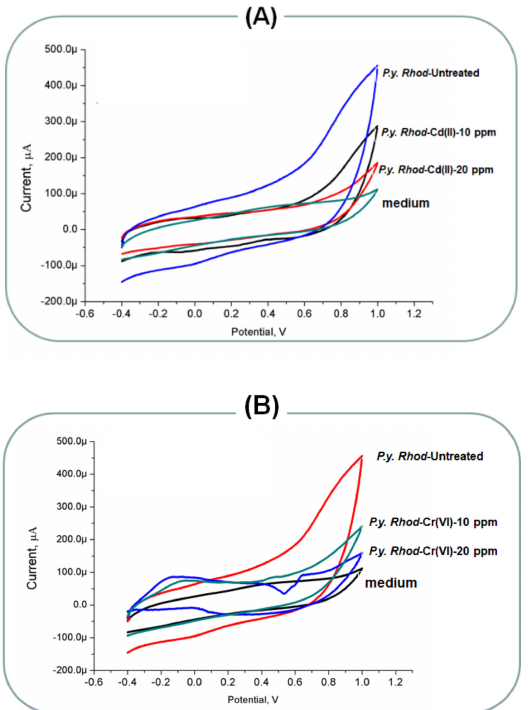
Figure 3. ( A ) Bio-electrochemical responses of biofilm formed Rhodotorula ALT72 treated with different concentrations of Cd(II). The untreated cells were considered as the positive control